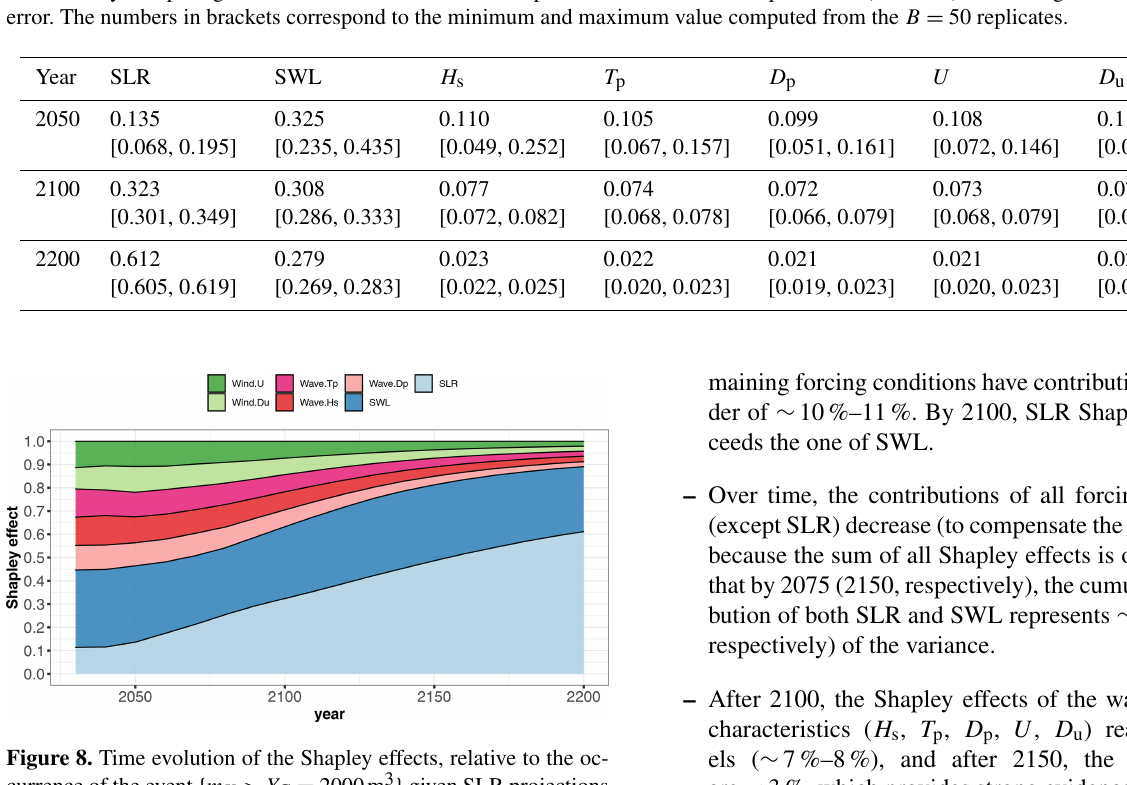
Table 1. Shapley effects relative to the occurrence of the event { m Y > Y C = 2000m 3 } given SLR projections for the scenario RCP4.5, estimated by computing the median value from B = 50 replicates of the estimation procedure (Sect. 3.5) accounting for GP and sampling error. The numbers in brackets correspond to the minimum and maximum value computed from the B = 50 replicates.